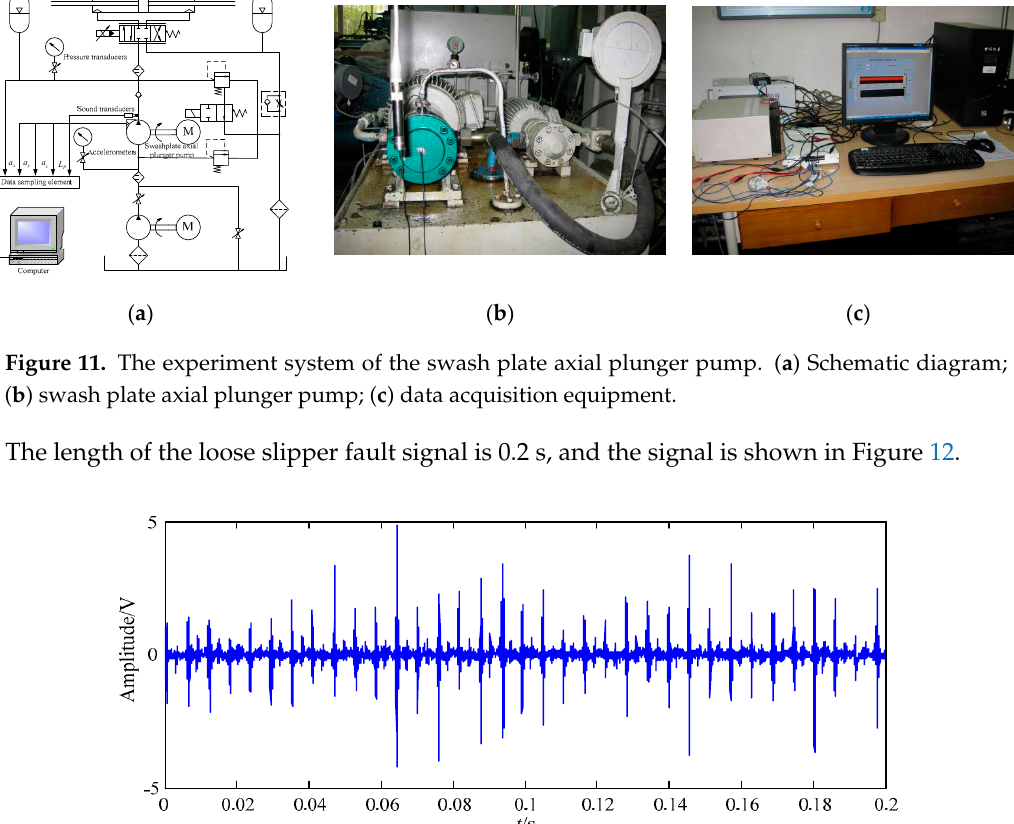
Figure 12. The loose slipper fault signal.